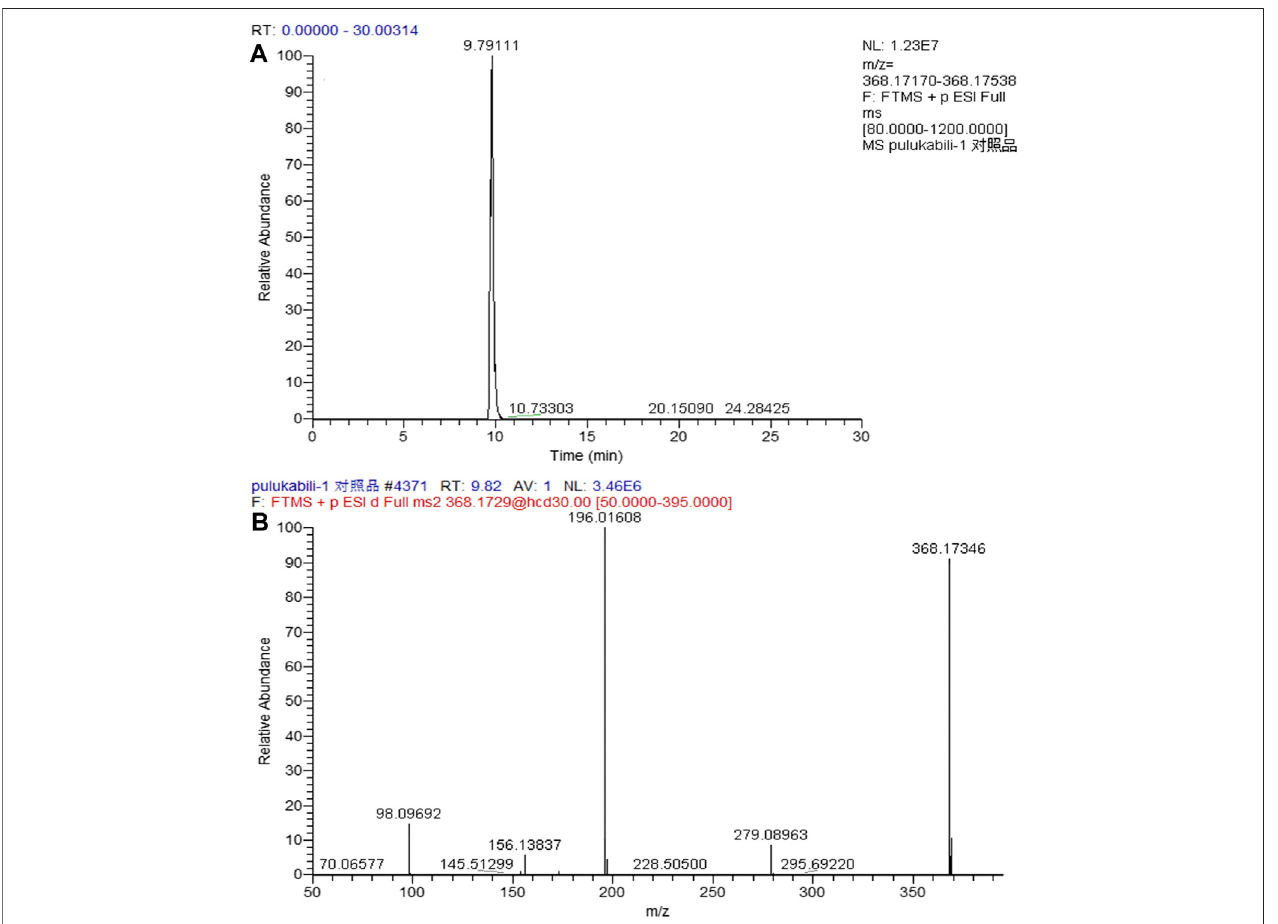
FIGURE 2 | The chromatogram (A) and mass spectrogram (B) of prucalopride in positive ion mode.